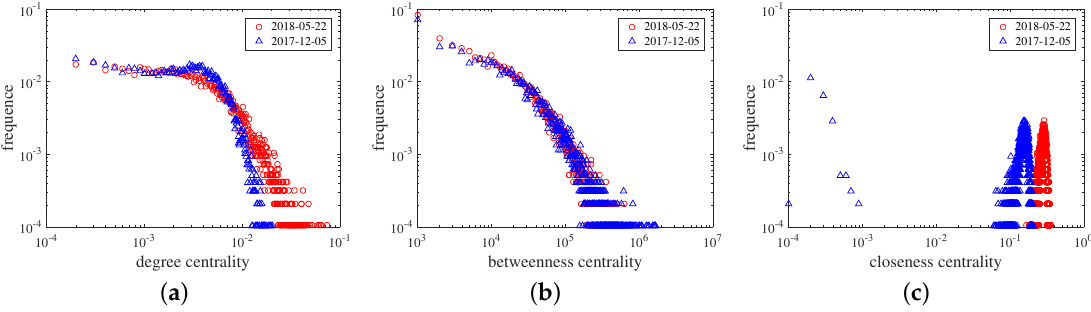
Figure 8. The comparison of the centrality distributions between the generated network in 5 December 2017 and the generated network in 22 May 2018. ( a ) Degree centrality distribution. ( b ) Betweenness centrality distribution. ( c ) Closeness centrality distribution. The red circle represents the real network, and the blue triangle represents the generated